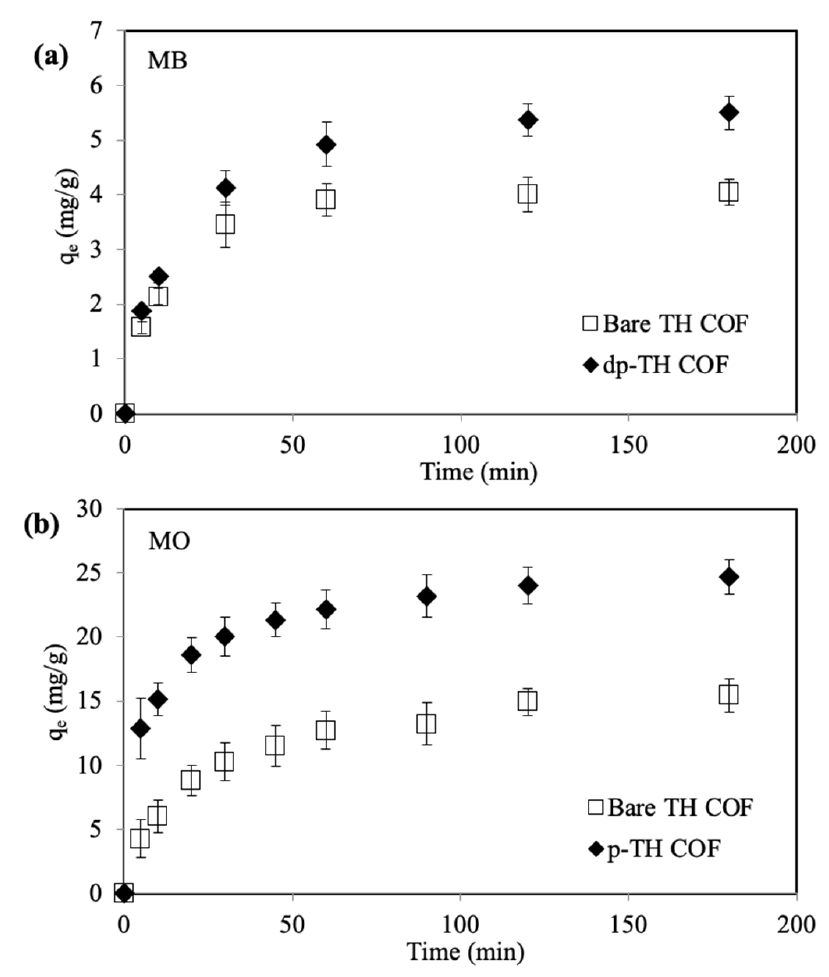
Figure 4. ( a ) Absorption amounts of MB dye by TH and dp-TH COFs, and ( b ) MO dyes by TH and p-TH COFs. (Reaction conditions: 100 mL 25 ppm dye solution, 0.05 g absorbent, 500 rpm, room temperature).